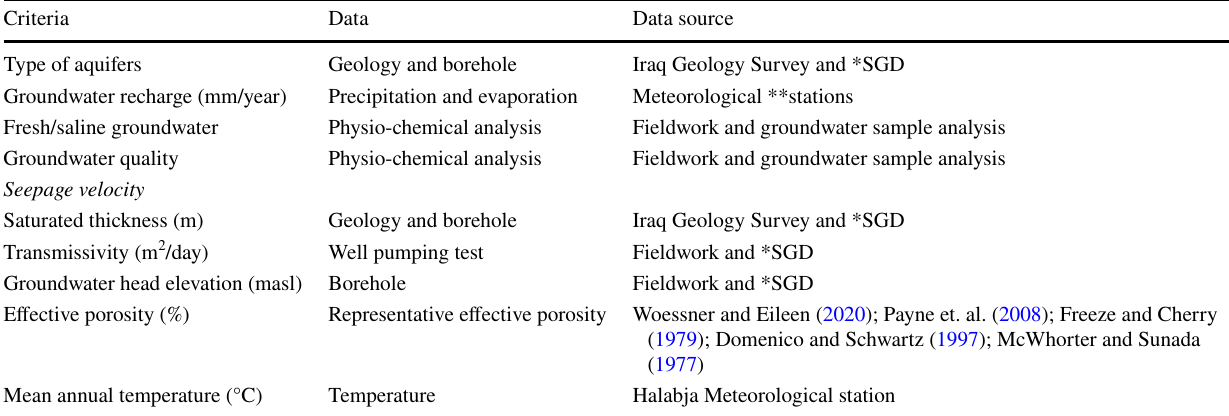
Table 1 Data source for creating criteria used in the ATES suitability map